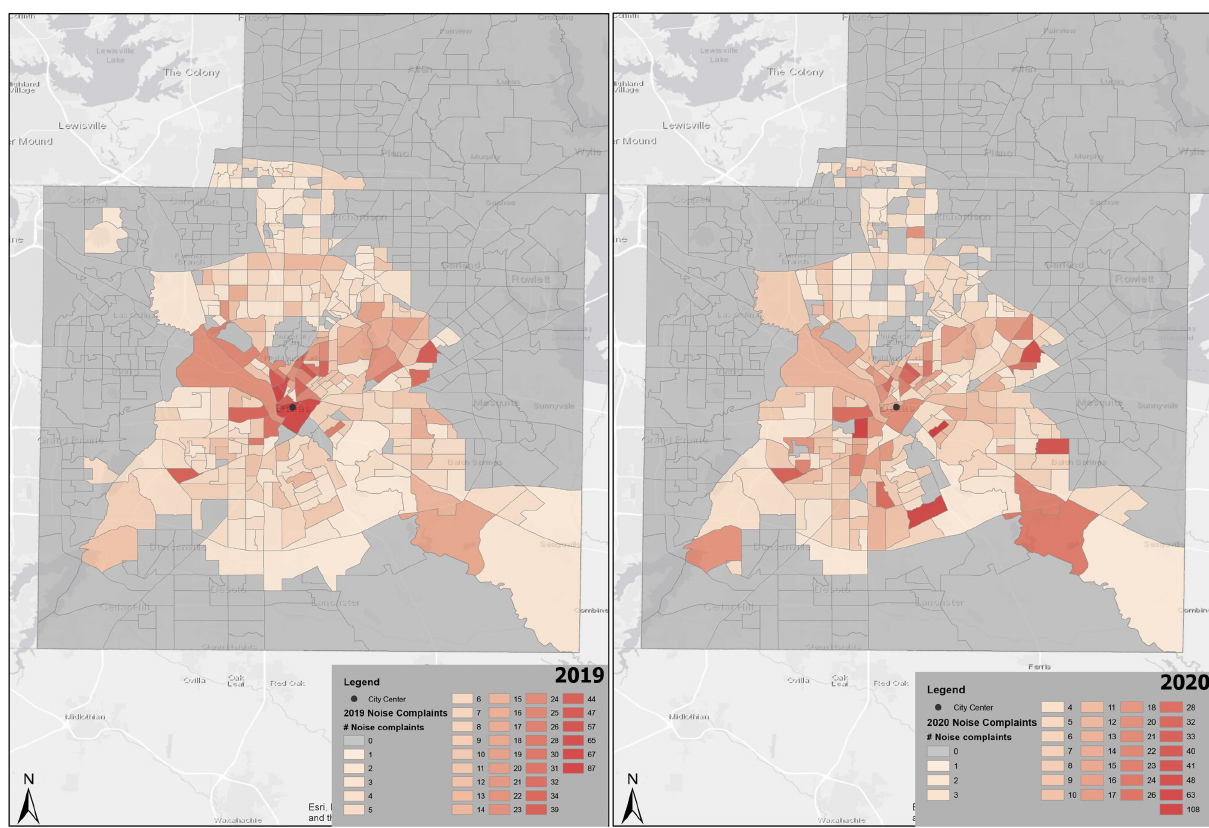
Figure 2: Noise complaints comparisons of before the COVID-19 and during the COVID-19 at the census tract level Table 1: Number of noise complaints and highest census tracts of buffer zones